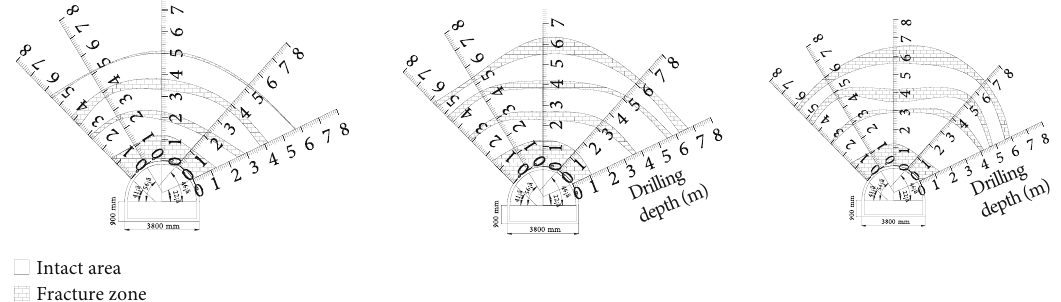
Figure 18: Zonal fracture of surrounding rock in 213 fl oor roadway of Qujiang Coal